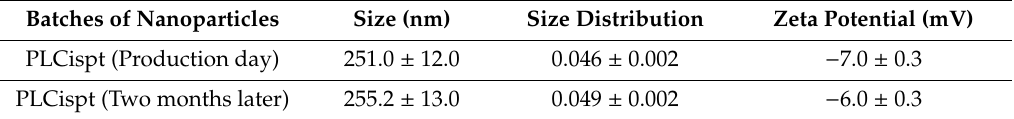
Figure 6. Evaluation of the cytotoxicity e ff ects of PLCispt at the production time compared to two months after the synthesis. The data are expressed as mean ± SD ( n = 3). Table 2. Size, size distribution, and zeta potential of PLCispt obtained at the production time and two months